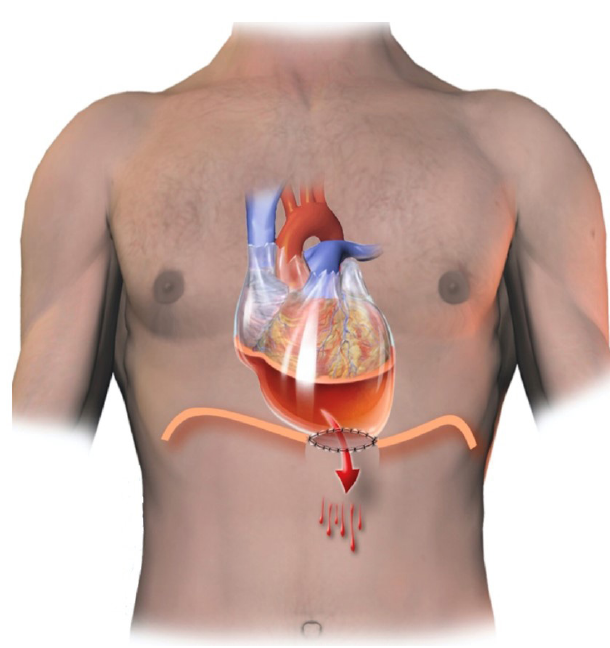
Fig. 1 - Schematic figure of the window created between the tissues of the pericardial and peritoneal